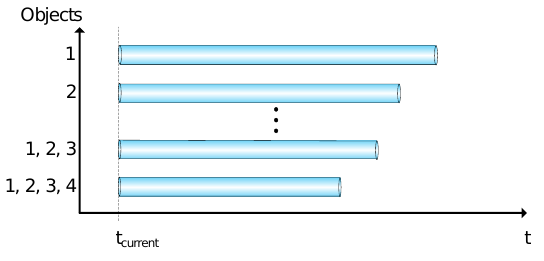
Figure 10: This scheduling graph exemplarily is showing in which time interval objects and groups of objects can be tracked.